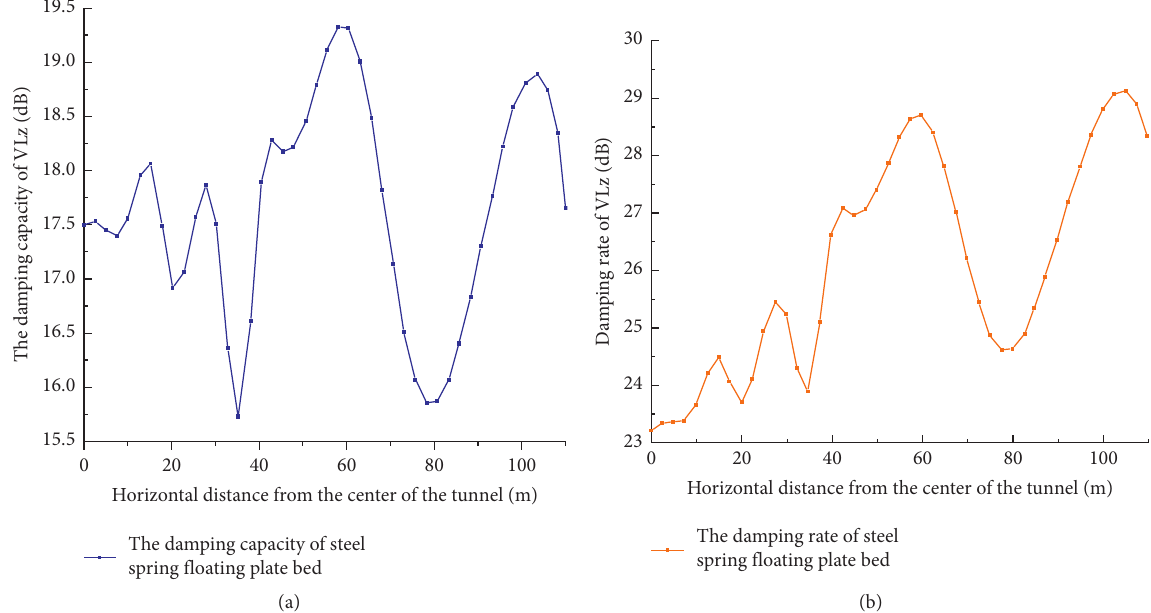
Figure 20: The variation law of damping capacity (a) and damping rate (b) of steel spring floating plate bed with horizontal